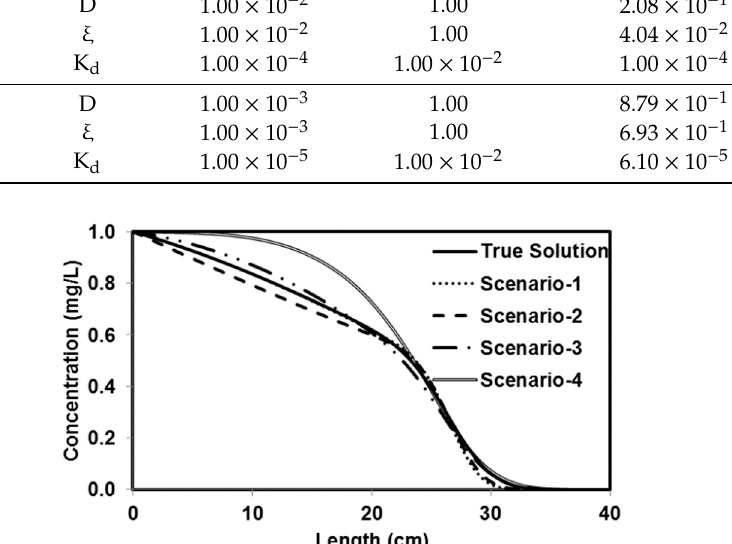
Figure 8. Comparison of different scenarios of the high and low bounds with the true solution for benchmark problem 1.